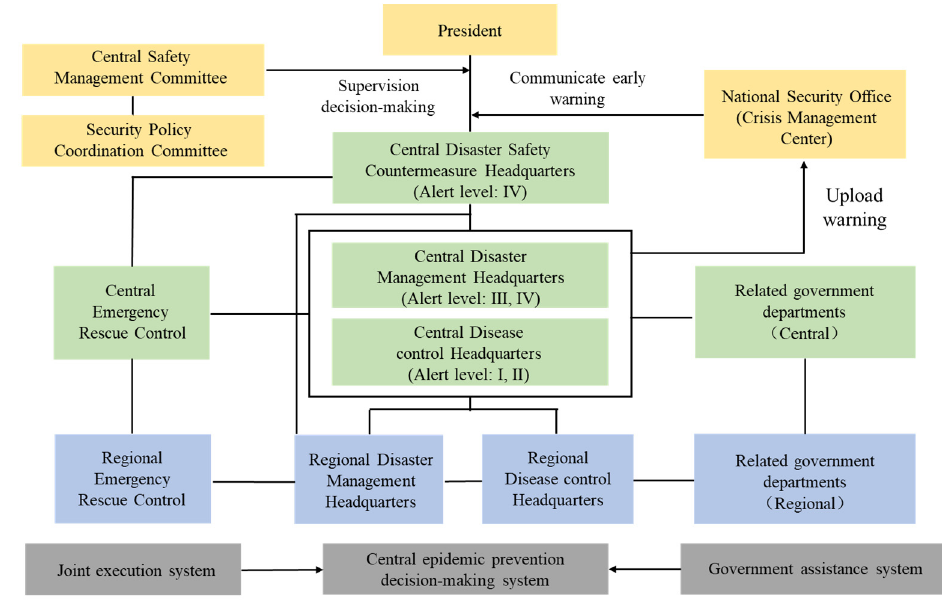
Figure 4. Korea’s infectious disease crisis management system.